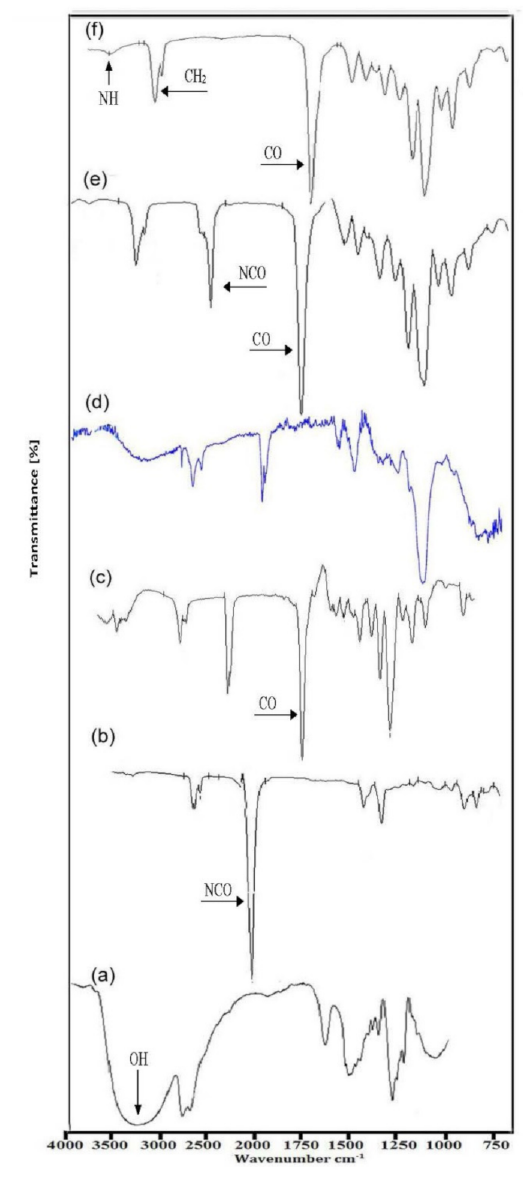
Figure 2. FT-IR spectra of ( a ) 1,4-Butanediol (BDO), ( b ) Isophrone diisocyanate, ( c ) Hydroxyl Termi- nated Polybutadiene (HTPB), ( d ) Xanthan Gum (XG), ( e ) NCO-terminated Prepolymer, and ( f ) XTPU final